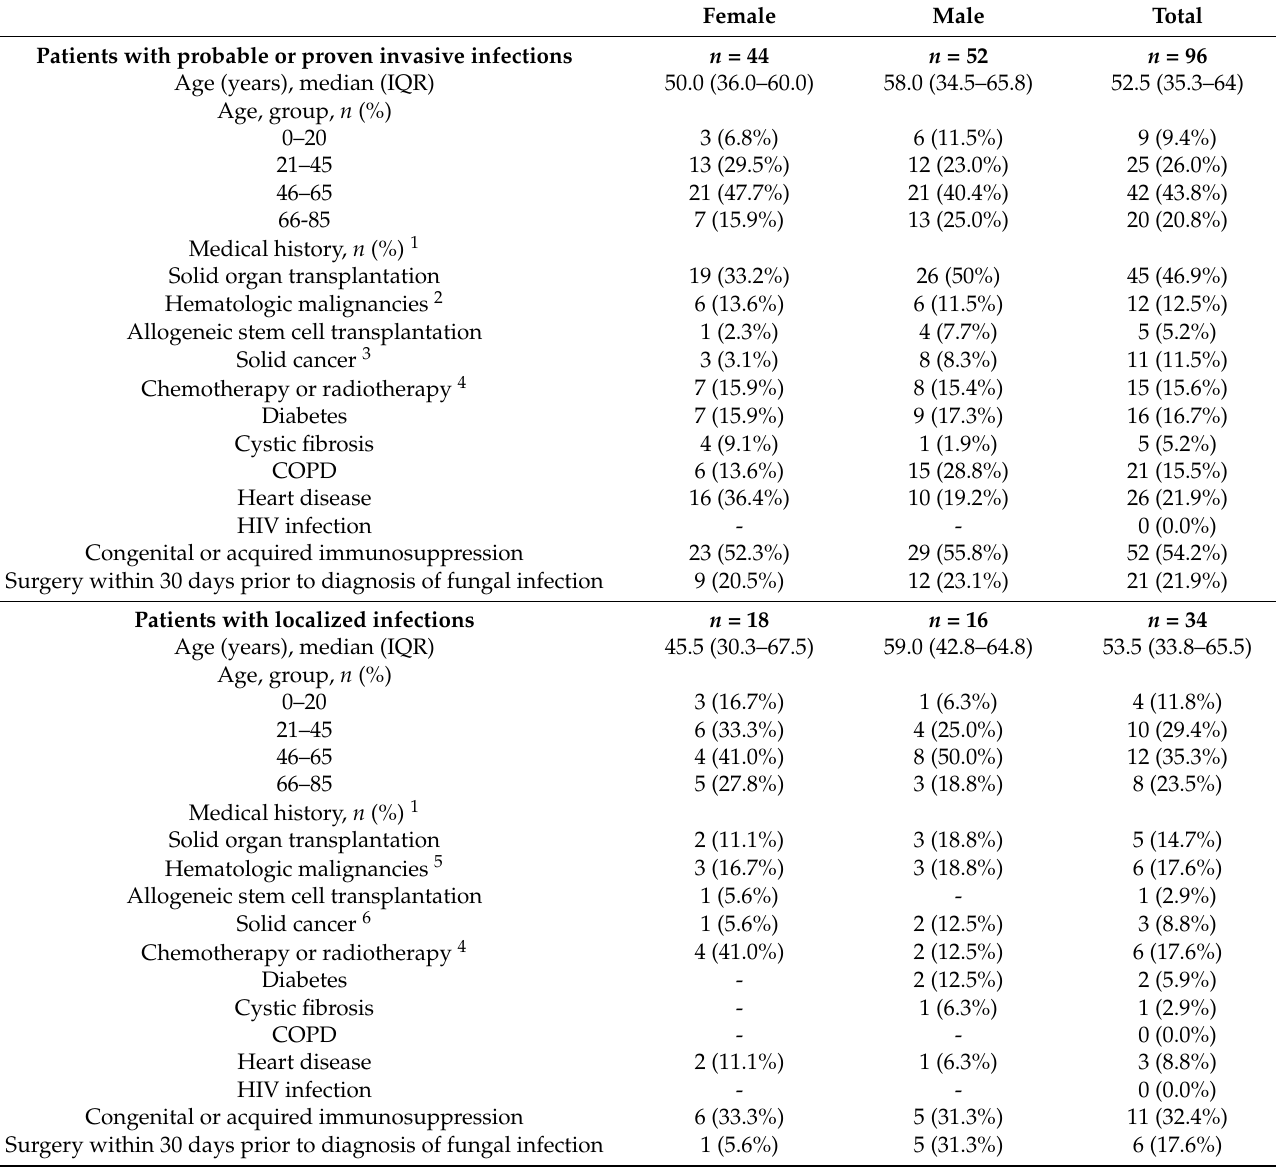
Table 1. Characteristics, risk factors, and underlying conditions upon diagnosis for patients with probable or proven invasive infection and localized infections ( n = 129). One patient had both an invasive and a localized